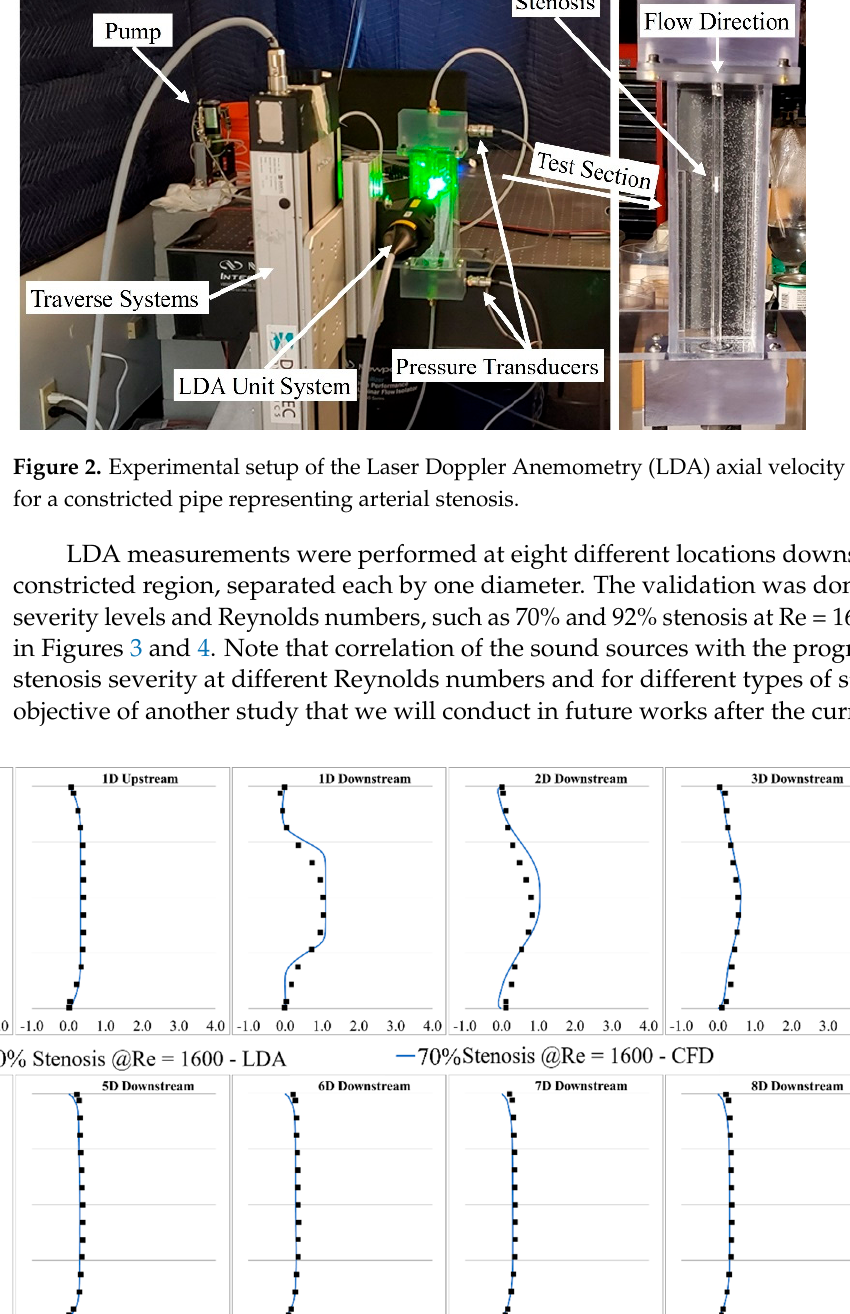
Figure 3. Validation of the computational results of 70% stenosis at Re = 1600 compared with the LDA measurements.